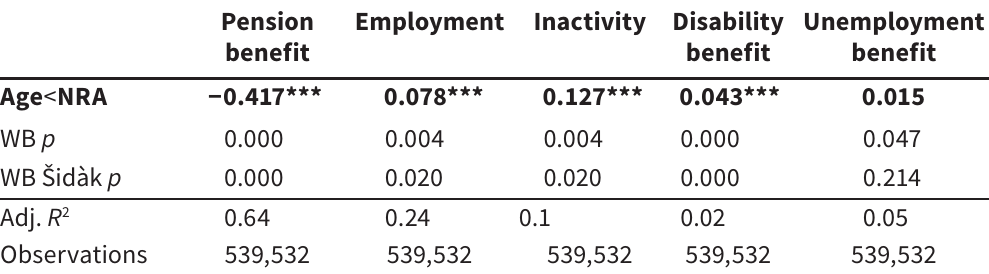
Table D3 Effect of raising the NRA: Eq. 2 excluding years 1992–1993 Pension Employment Inactivity Disability benefit